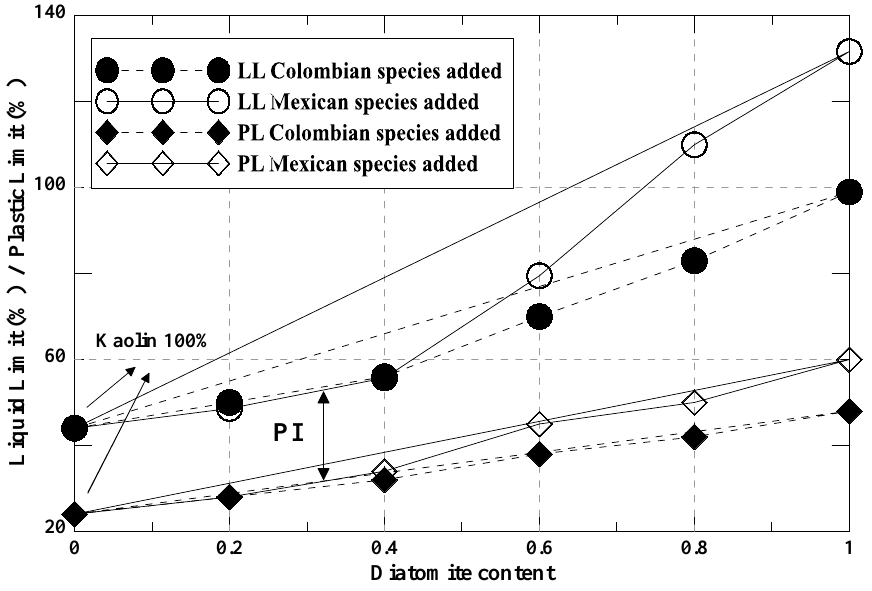
Figure 4. Liquid limit (LL) and plastic limit (PL).